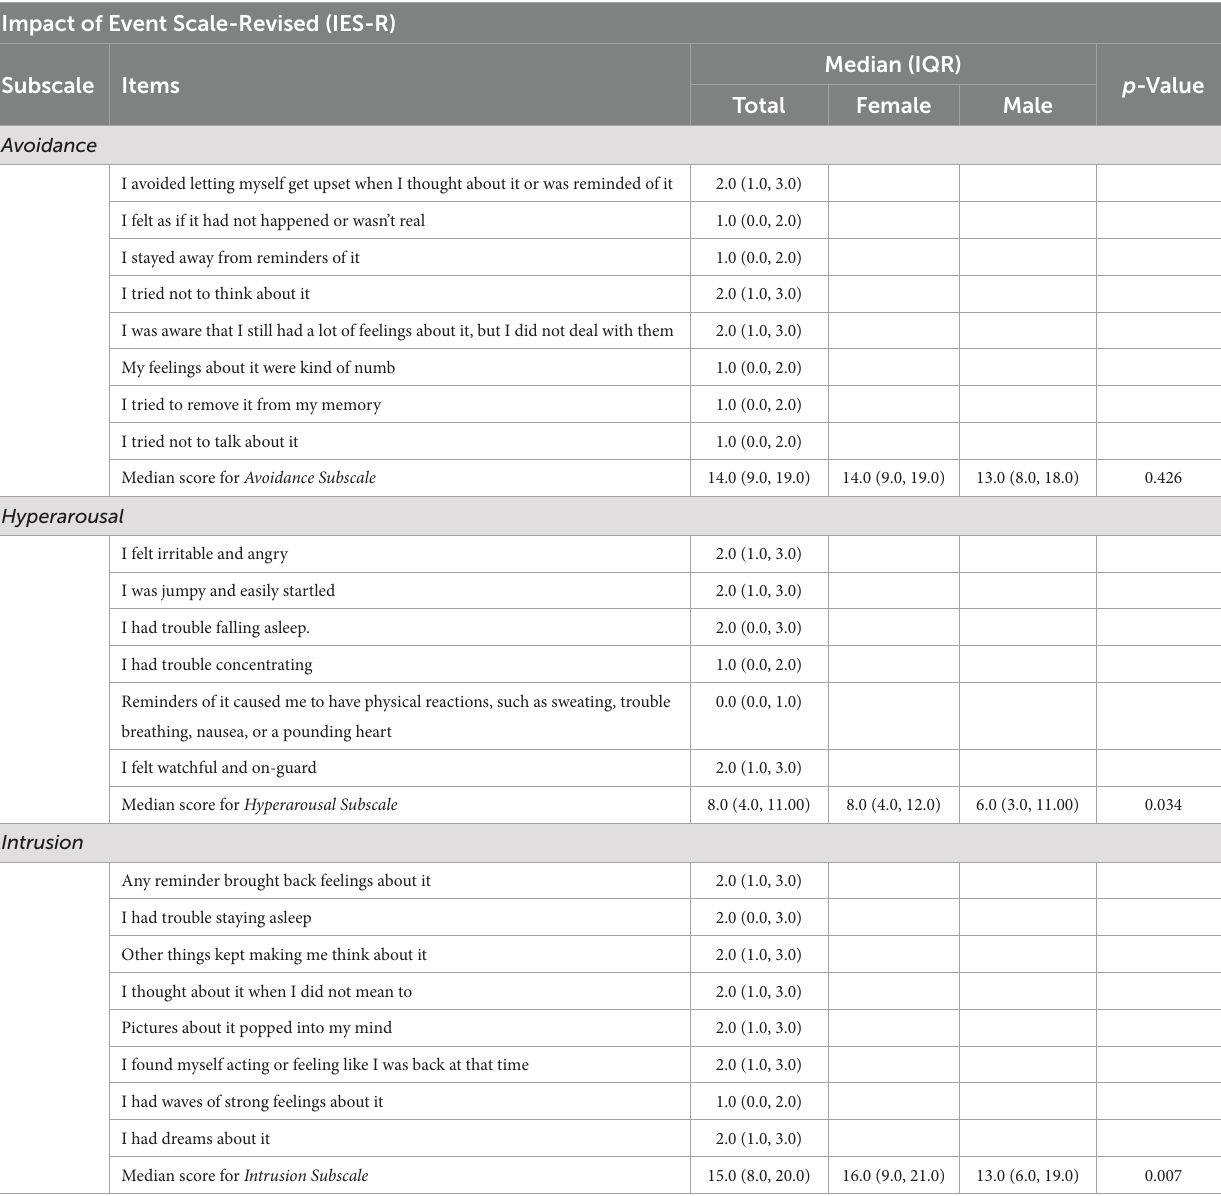
TABLE 5 IES-R subscale scores in the study sample and by gender. Impact of Event Scale-Revised (IES-R)